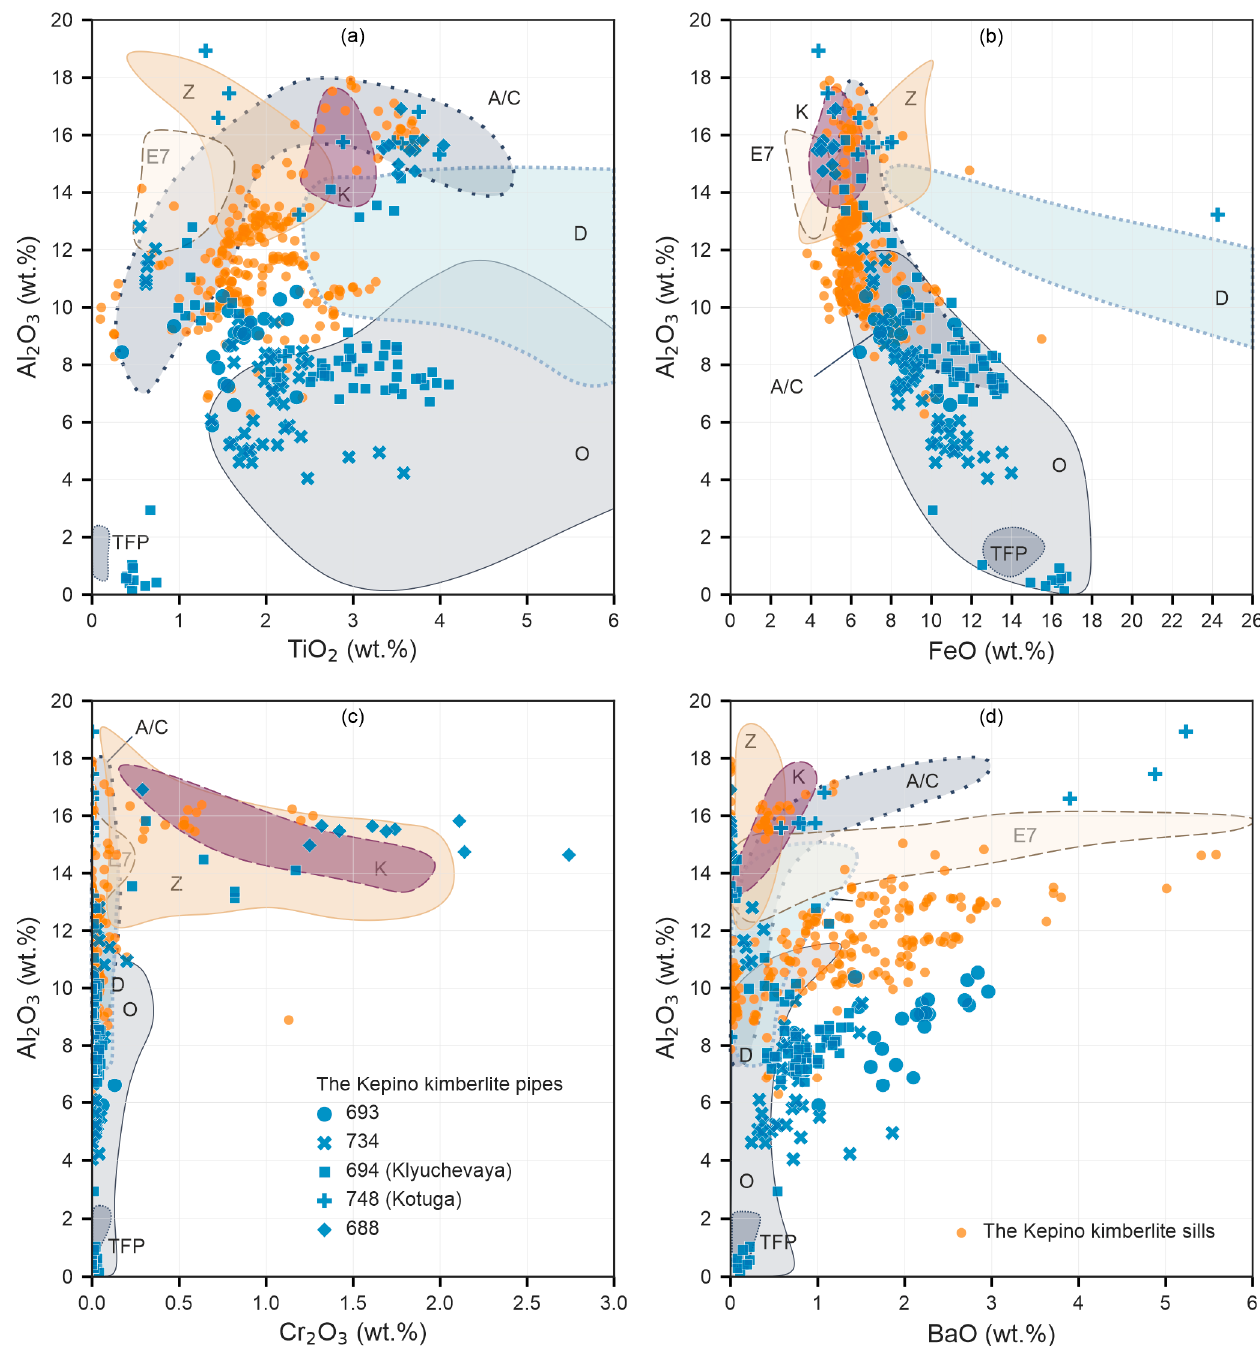
Figure 7. Bivariate plots Al 2 O 3 vs. FeO ( a ), Al 2 O 3 vs. Cr 2 O 3 ( b ), Al 2 O 3 vs. TiO 2 ( c ), Al 2 O 3 vs. BaO ( d ) for the phlogopite from the Kepino cluster kimberlites with detalisation for kimberlite pipes. The “K” field is for phlogopite phenocrysts and microphenocrysts from pyroclast groundmass and kimberlite matrix from the Grib kimberlite, ADP, based on [57]. The “O” field is for phlogopite from orangeites of Kostomuksha, Karelia, Russia, based on [60]. The “Z” field is for phenocrysts and microphenocrysts kimberlites of the Zolotica cluster, ADP (Supplementary Materials, Table S2). The “E7” field is for phlogopite from Ermakovskaya-7 pipe, Kola Peninsula (Supplementary Materials, Table S2). “A/C”, “D” and “TFP” fields are for phlogopite from ultramafic lamprophyres and carbonatites from Aillik Bay, Canada, based on [59]: “A/C”—aillikites and carbonatites; “TFP”—tetraferriphlogopite rims from aillikites; “D”—damtjernites and mela-aillikites.